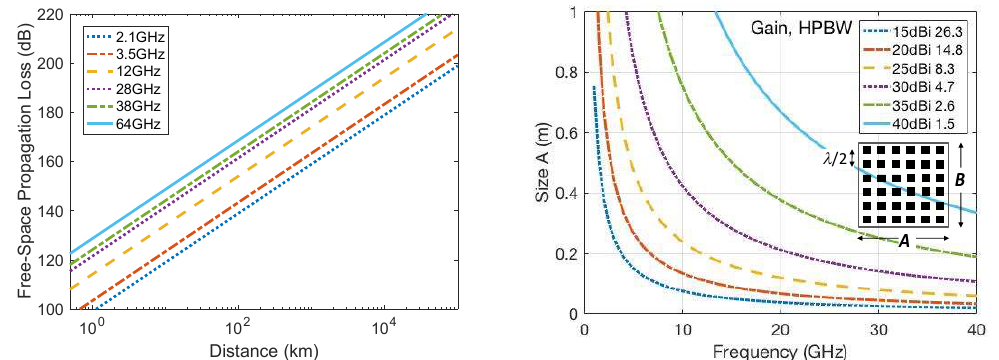
Figure 3. ( Left ) Free-space propagation loss a fs = 20 · lg 4 π d λ , where d is the distance between the communication partners, λ = c 0 is the wavelength, c 0 is the speed of light, and f 0 is the operating frequency as a parameter for two 5G sub-6 GHz bands as well as some micro- and millimeter wave frequencies allocated for future 5G and satellite platforms (see Appendix A). ( Right ) Calculated gain G = ε ap · 4 π λ ∙ 𝐴 (cid:2870) and half-power beamwidth 𝐻𝑃𝐵𝑊 = 𝑘 ∙ (cid:3090) in degrees of a quadratic antenna array with size A = B and with radiating element distances of 𝜆/2 , assuming an aperture efficiency of 𝜀 (cid:3028)(cid:3043) = 0.4 and –10dB-taper of the aperture field with k =1.15.